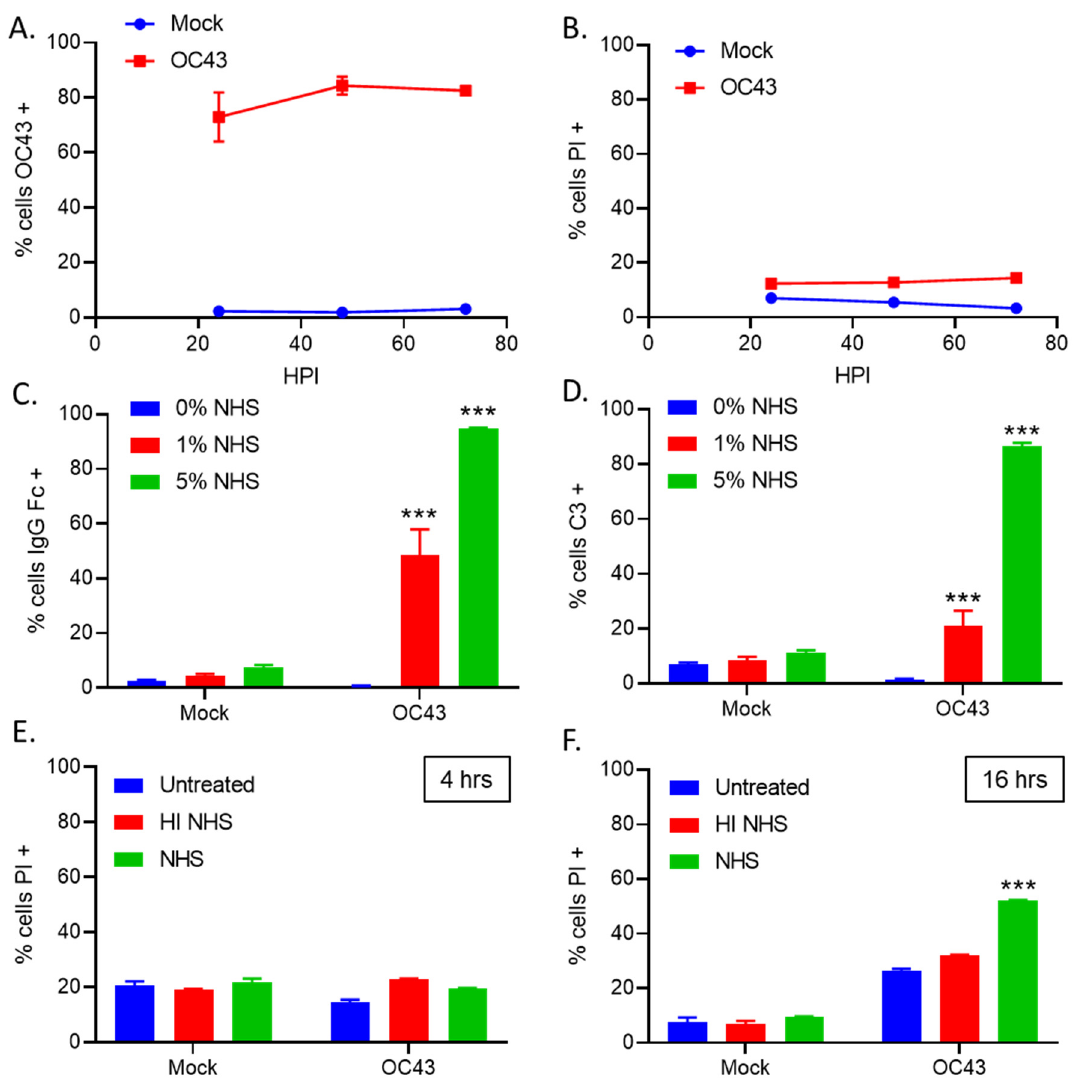
Figure 1. NHS treatment of OC43 infected lung cells results in deposition of antibodies and C3. ( A , B ) Human H1299 lung cells were uninfected (mock) or infected with OC43 at an MOI of 5 TCID 50 units per cell. Cells were stained for intracellular NP expression ( A ) and cell viability was determined by PI staining ( B ) at 24, 48, and 72 hpi. ( C , D ) H1299 cells were uninfected (mock) or infected with OC43 at an MOI of 5 TCID 50 units per cell. Two dpi, cells were either untreated, or treated with 1% or 5% NHS for 1 h at 37 °C. Cells were washed and stained for surface antibody Fc ( C ) or C3 deposition ( D ). ( E , F ) H1299 cells were uninfected (mock) or infected with OC43 at an MOI of 5 TCID 50 units per cell. Two dpi, cells were either untreated or treated with 10% HI NHS or NHS for 4 h ( E ) or 16 h ( F ) at 37 °C. Values in all panels are the mean of three replicates and error bars representing standard deviation, with *** indicating p -value of <0.001 comparing HI NHS treatments versus PBS control ( A ), NHS treated OC43 infected versus NHS treated uninfected (mock) samples ( D , E ), or NHS treated OC43 infected versus HI NHS treated OC43 infected samples ( F ). Mock denotes uninfected control samples.